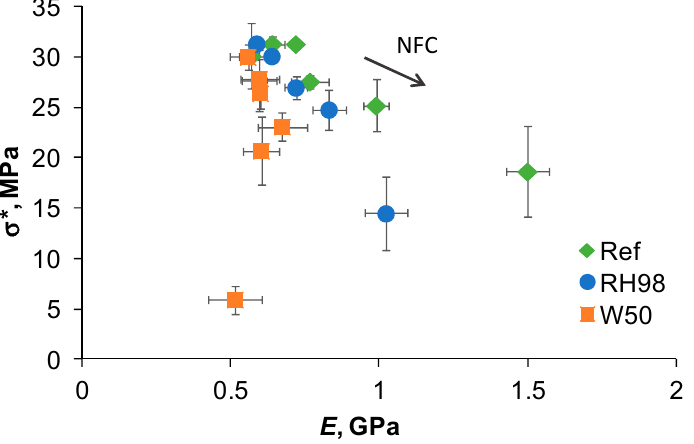
Figure 7. Strength versus elastic modulus of PBS/NFC reference and aged samples.